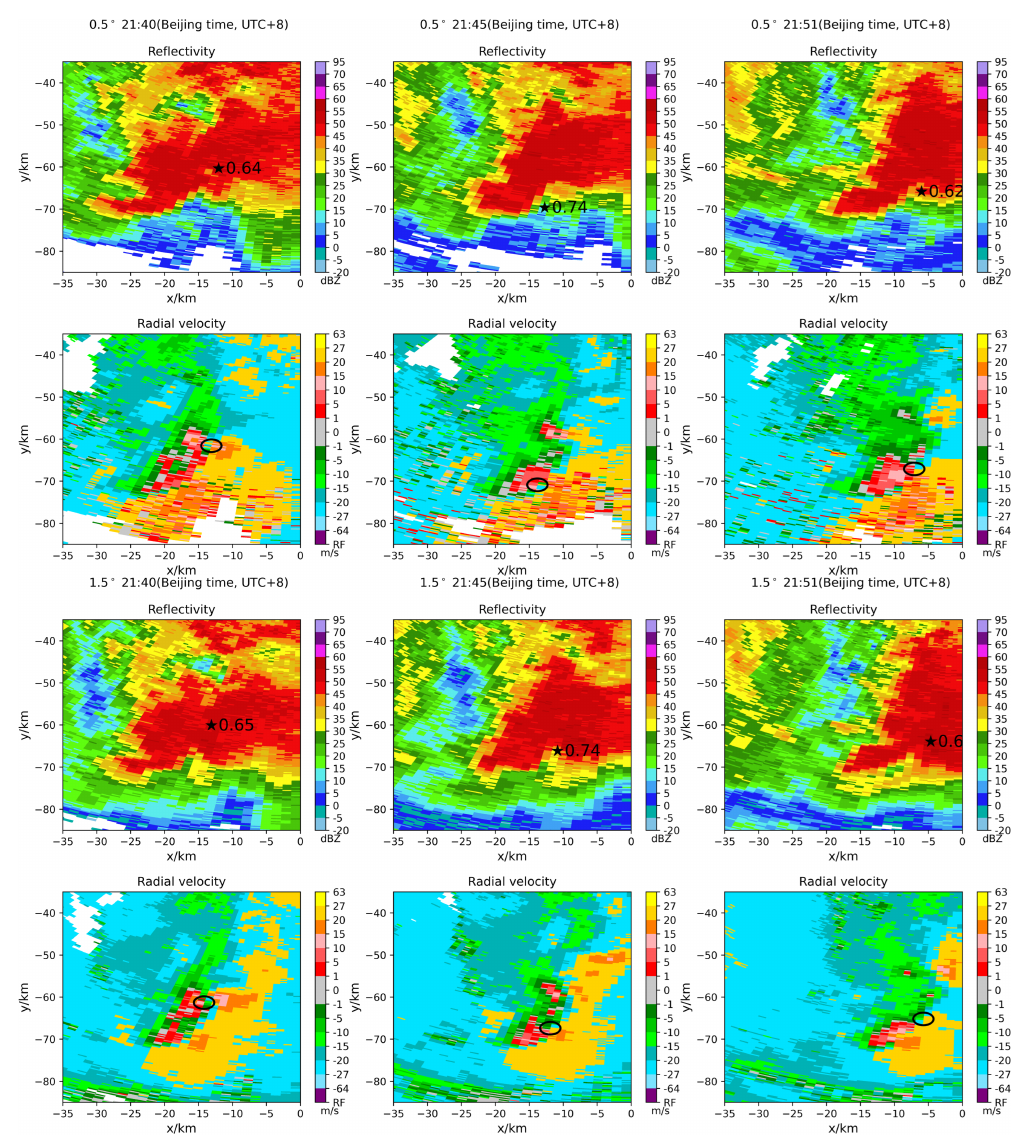
Figure A5. The TDA-RF detection results on radar Z9518, 0.5 ◦ and 1.5 ◦ , Z9518-2020-0722 21:40 to 21:51 (UTC+8), the tornado was EF1. (asterisk corresponds to the identification center, and the value corresponds to the probability; the black circle has a radius of 1.5 km centered on the identification result; no asterisk and circle indicate that the TDA-RF did not recognize the